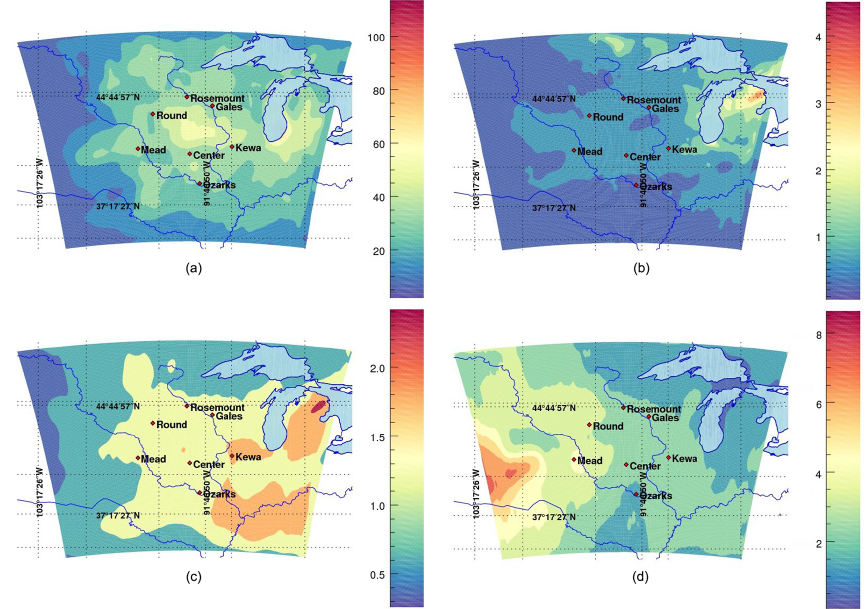
Figure 6. Filtered variances using the calibrated 25-member ensemble of in situ CO 2 mole fractions at 100ma.g.l. (in ppm 2 ) (a) , in situ CO 2 mole fractions at 5kma.g.l. (in ppm 2 ) (b) XCO 2 total dry air mole fractions (in ppm 2 ) (c) and PBLH (in m 2 ) (d)